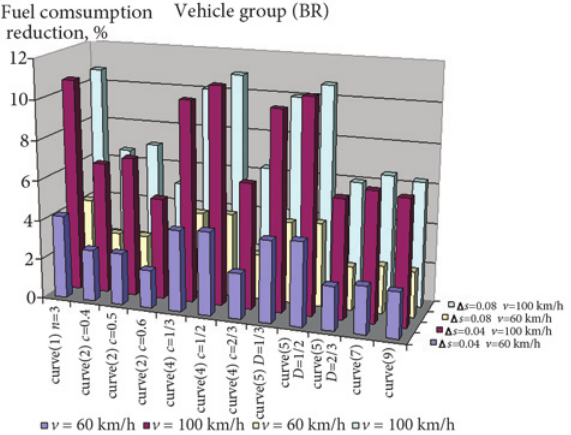
Fig. 12. Fuel consumption reduction in variant B, % in vehicle group (BR)